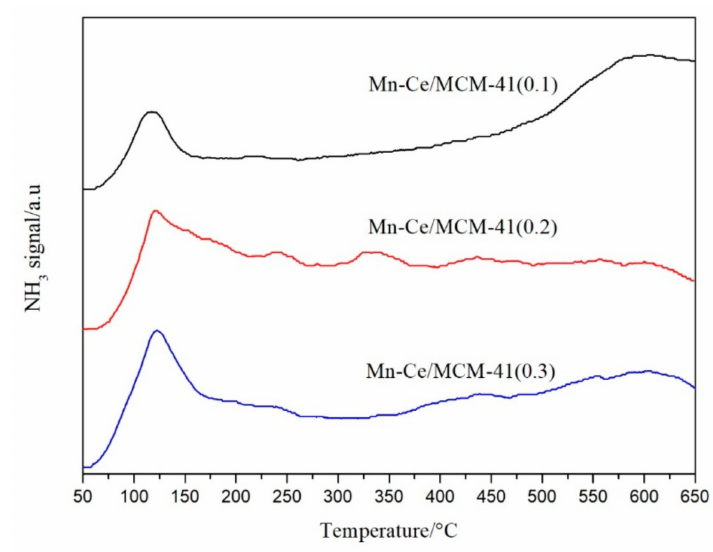
Figure 13. NH 3 -TPD diagram of catalytic materials with di ff erent ratio of template.